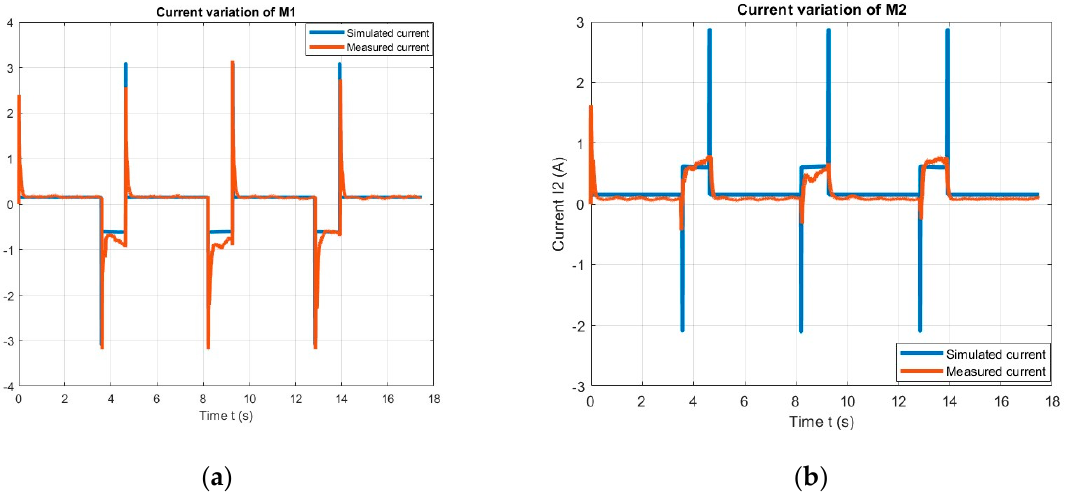
Figure 36. Variation in the simulated and measured current. ( a ) Wheel 1 (similar to wheel 3). ( b ) Wheel 2 (similar to wheel 4). Table 8. Comparison between simulated and measured current—data statistics for motor M1. Description